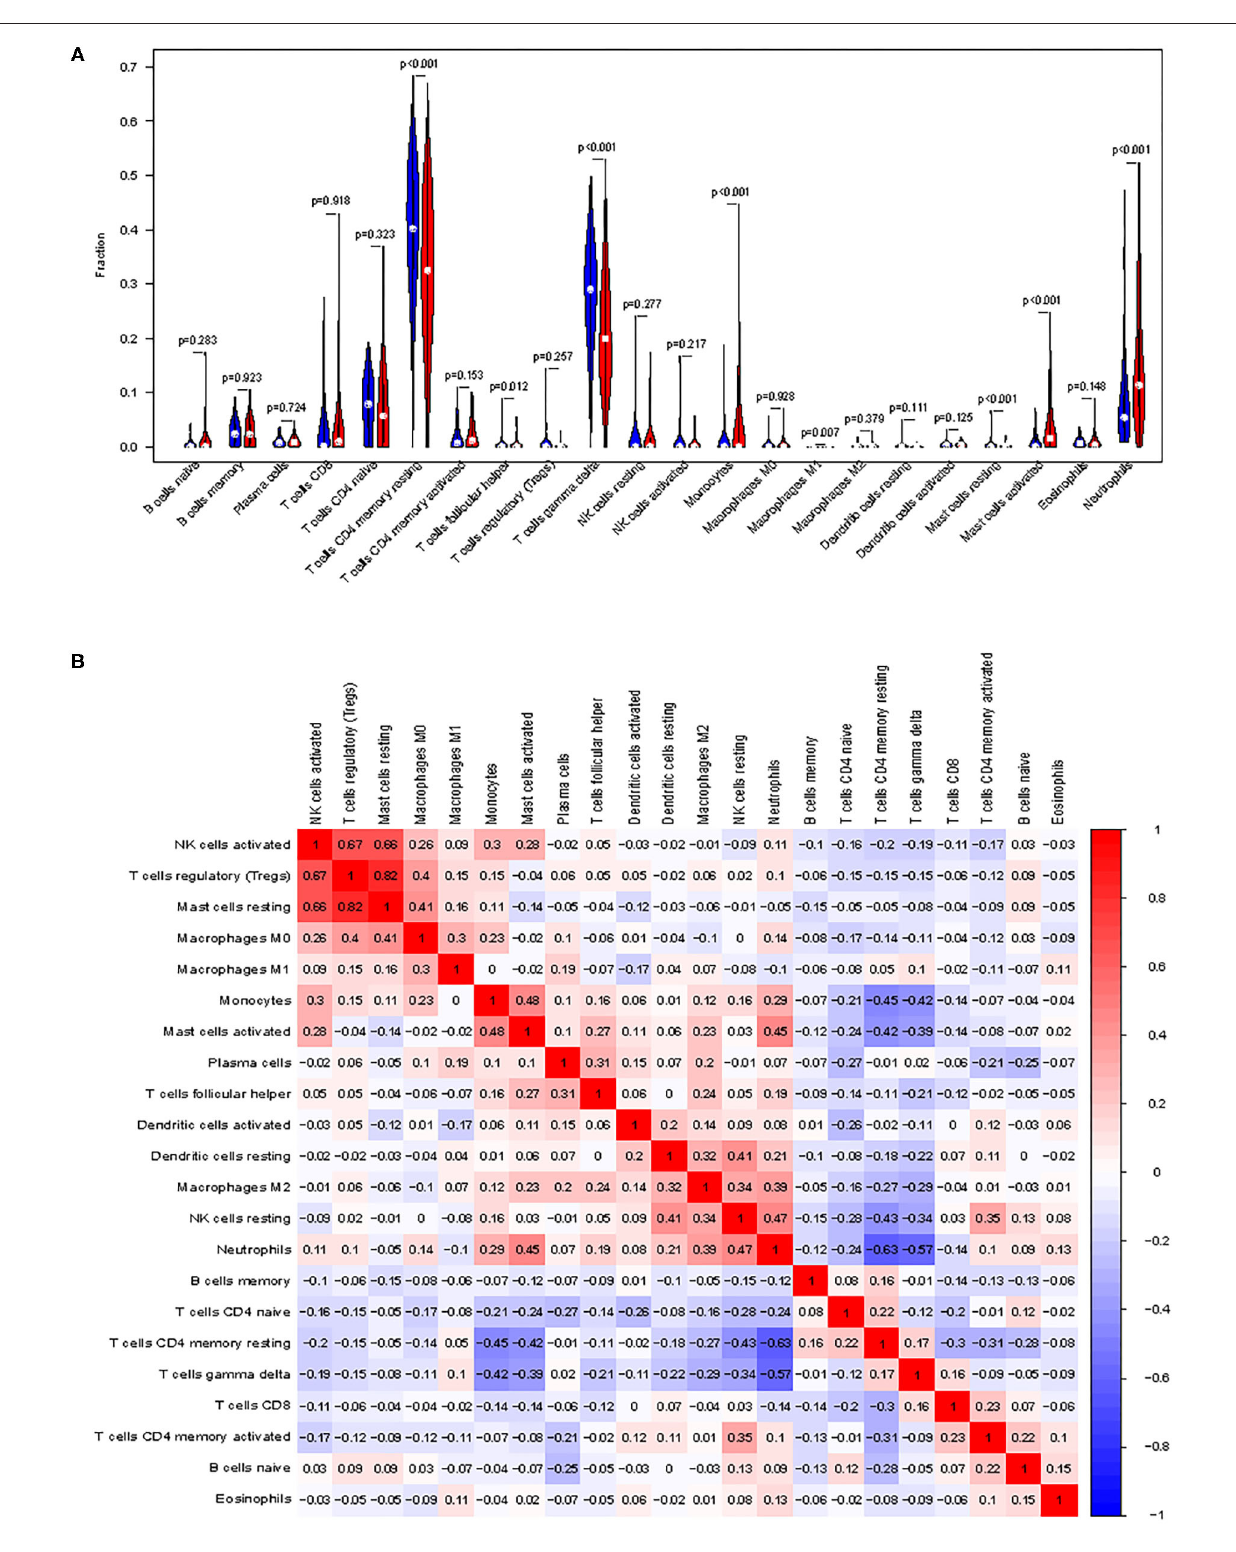
Frontiers in Cardiovascular Medicine | www.frontiersin.org